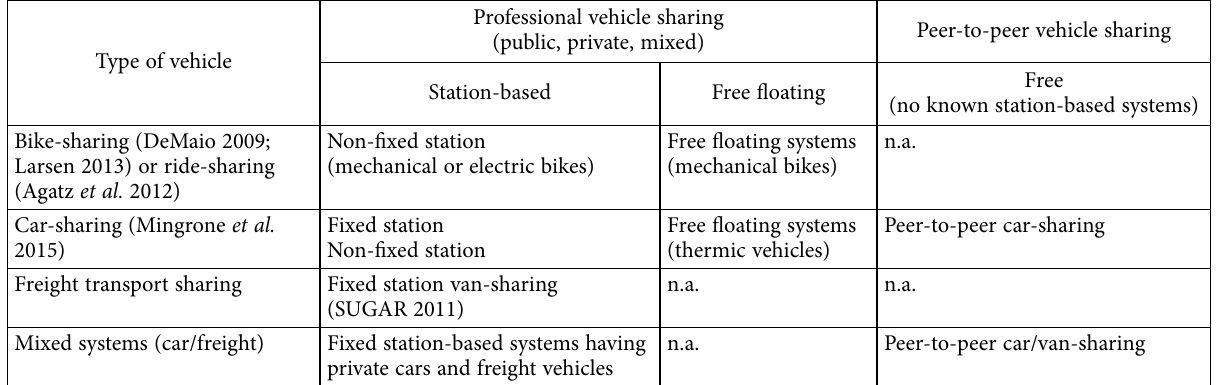
Table 2. Main types of vehicle sharing